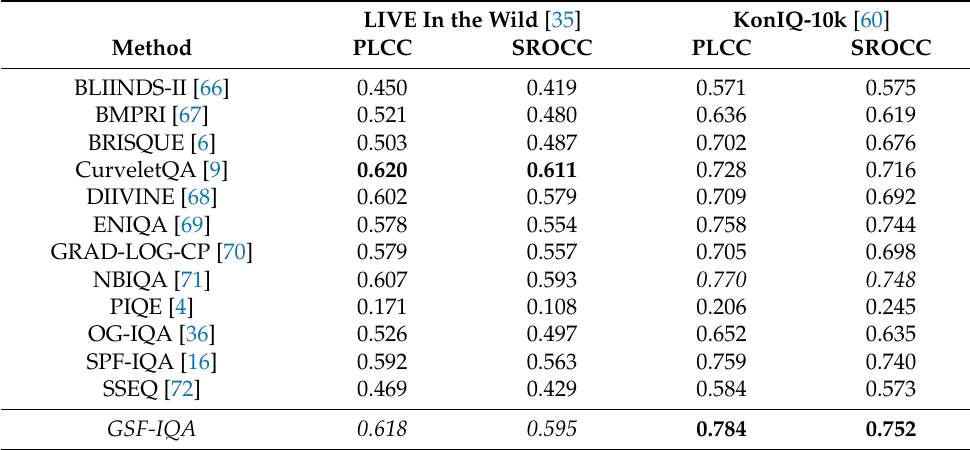
Table 6. Comparison of GSF-IQA to the state-of-the-art on authentic distortions. Mean PLCC and SROCC are measured over 100 random train–test splits. Best results are typed in bold, second best results are typed in italic.